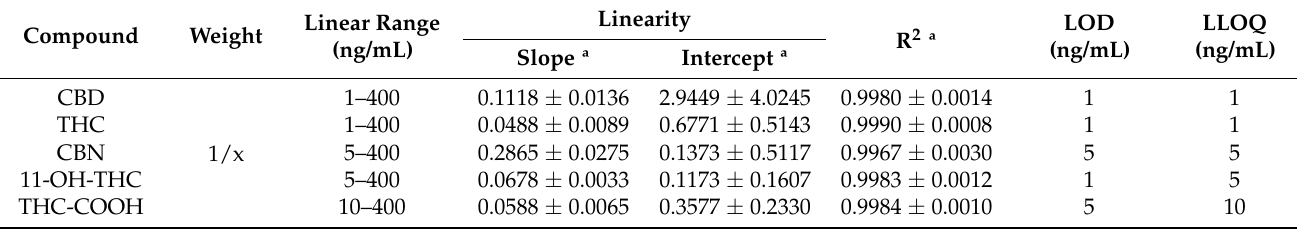
Figure 3. Chromatogram of a blank sample. Table 1. Linearity data (n =